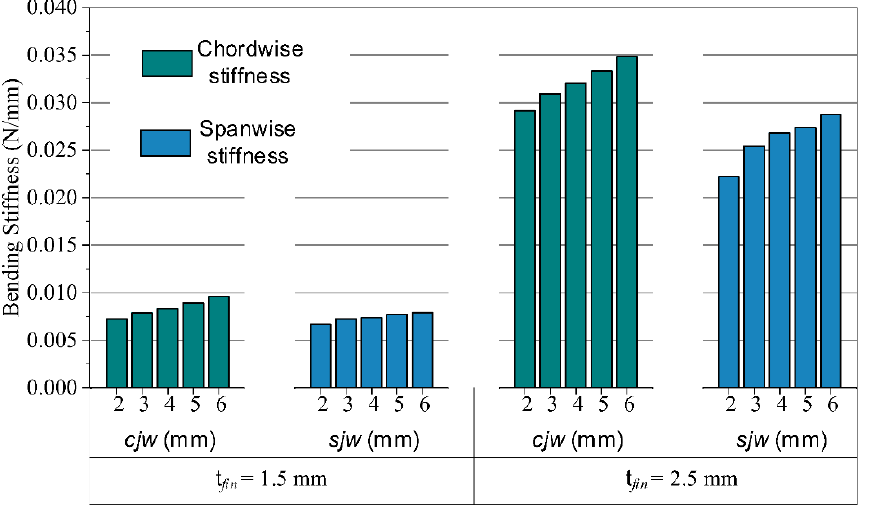
Figure 3. The chordwise and spanwise bending stiffness of the CJF.